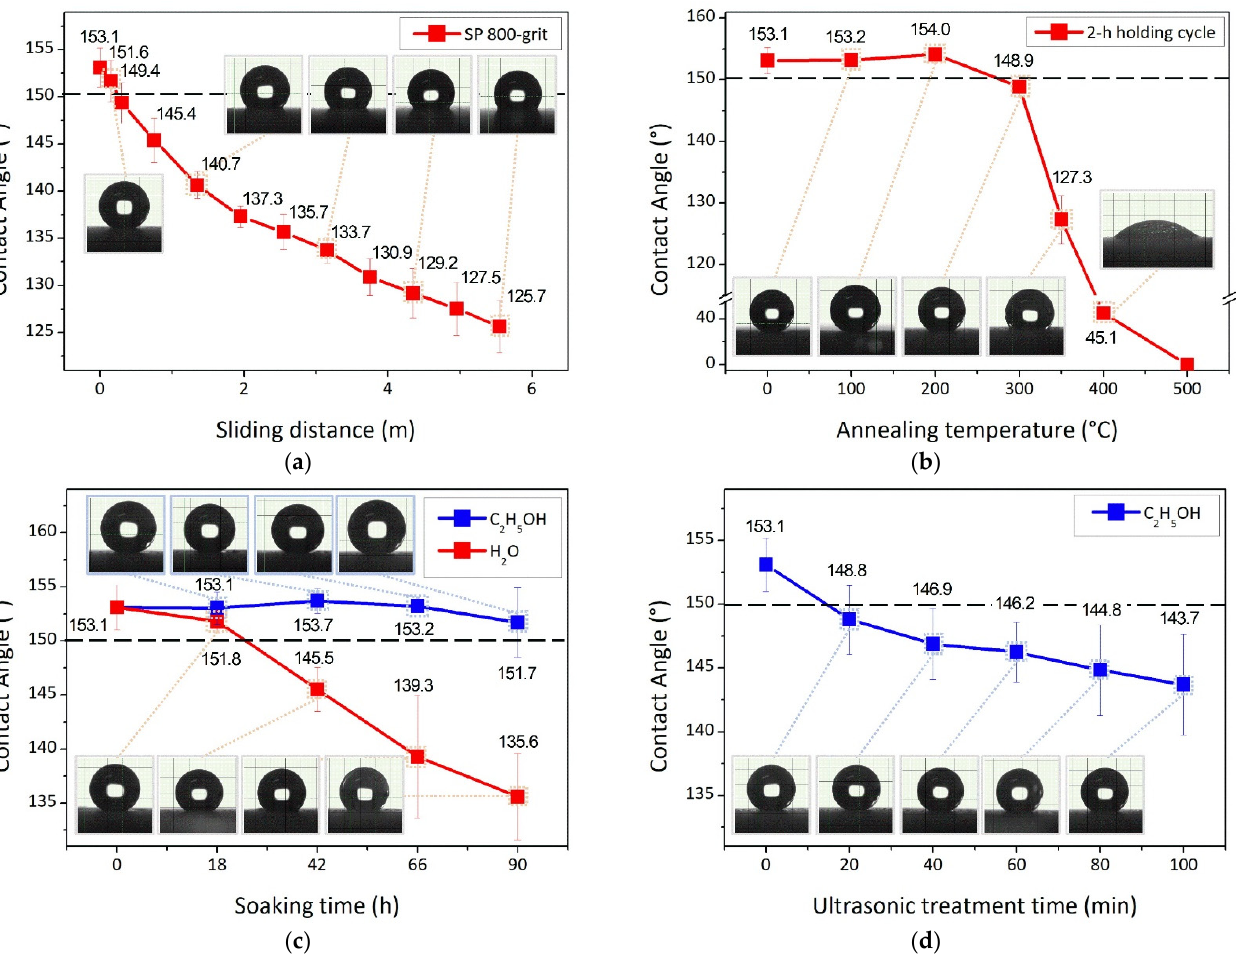
Figure 33. Wettability of SiO2–F coating sprayed on alumina substrate as a measure of contact angle after durability test being: ( a ) abrasive wear test on 800-grid sandpaper, ( b ) heat treatment in 2-h annealing cycles, ( c ) immersion in water and absolute alcohol and (d) ultrasonic bath treatment in absolute alcohol. The dashed line represents the superhydrophobic limit for CA being 150° [242].